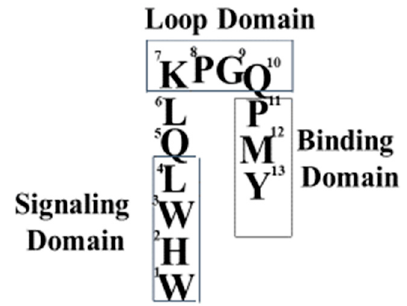
Figure 3. Biologically active conformation of α -factor. The tridecapeptide is flexible around residues 7–10, which we believe form a β -turn-like loop. After the three C-terminal residues of the peptide bind to Ste2p, the loop region allows the “bending” of α -factor to form a conformation in which the three N-terminal residues productively interact with Ste2p to initiate signal transduction.